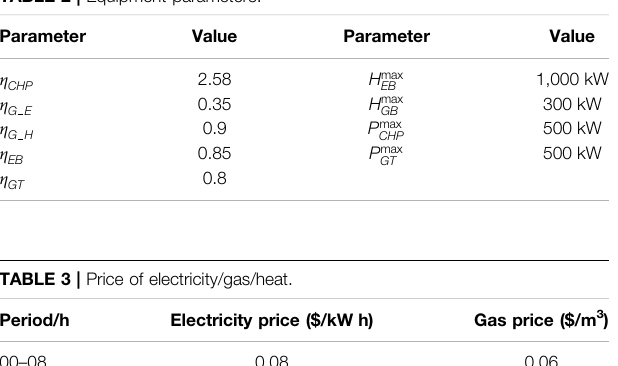
TABLE 2 | Equipment parameters.